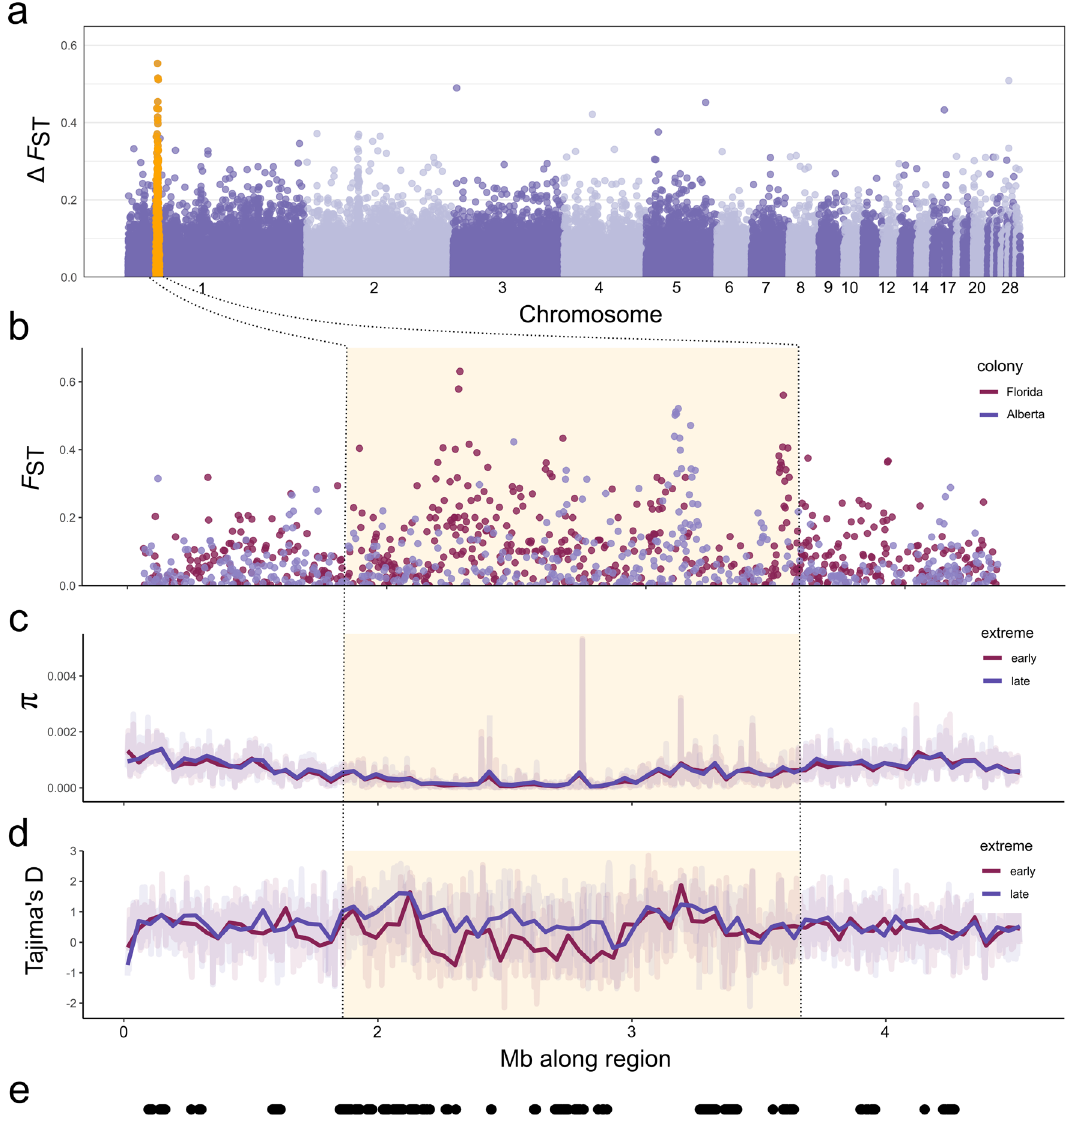
Figure 3. ( a ) Net genetic differentiation (Δ F ST ) across autosomes in 5 kb non-overlapping windows between earliest and latest spring migrants. The elevated region on chromosome 1 (defined as scaffolds with homology to chicken chromosome 1) is highlighted in orange, with plots examining this region to show ( b ) F ST between early and late migrants within Alberta and within Florida, ( c ) nucleotide diversity (π) between earliest and latest migrants, ( d ) Tajima’s D between earliest and late migrants, and ( e ) location of genes in this region as black